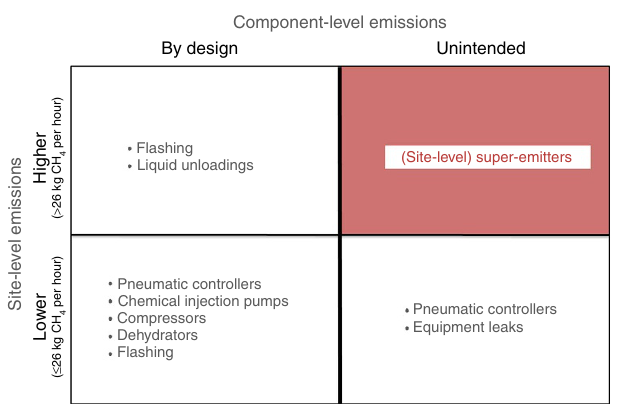
Figure 1 | Classification of sites in terms of magnitude of emissions and component behaviour. The vertical axis classifies sites in terms of magnitude of total site-level emissions (where 26kg CH 4 per hour is the threshold for higher emitters). The horizontal axis classifies sites in terms of component behaviour that results in emissions (emissions by design versus unintended). The bullets in each quadrant indicate the components that were included in our component-based aggregation model; these represent all known sources of emissions on natural gas production sites in the Barnett Shale. The shaded quadrant accounts for the existence of abnormal process conditions that result in high, unintended emissions, the defining characteristic of super-emitting